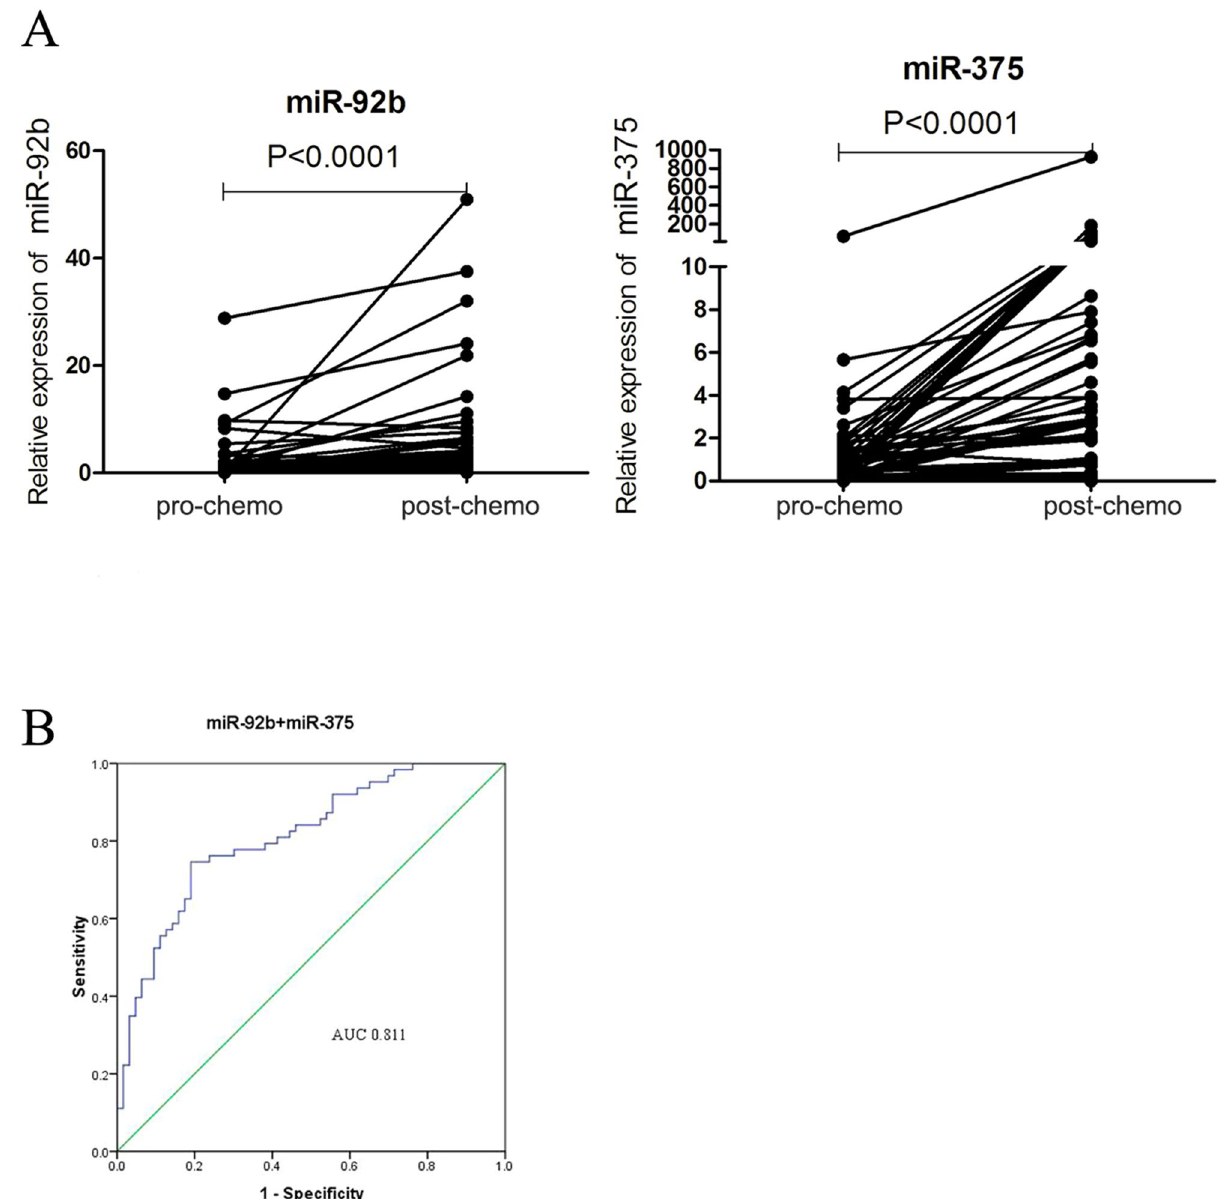
Figure 3. Circulating miRNA levels during treatment and ROC analysis of a two-miRNA panel. ( A ) miR-92b and miR-375 in SCLC patient plasma at the stages of both pre- and post-chemoresistance. ( B ) AUC estimation for miRNAs in discriminating between pre- and post-chemoresistant patients in the set of 38 SCLC patients.